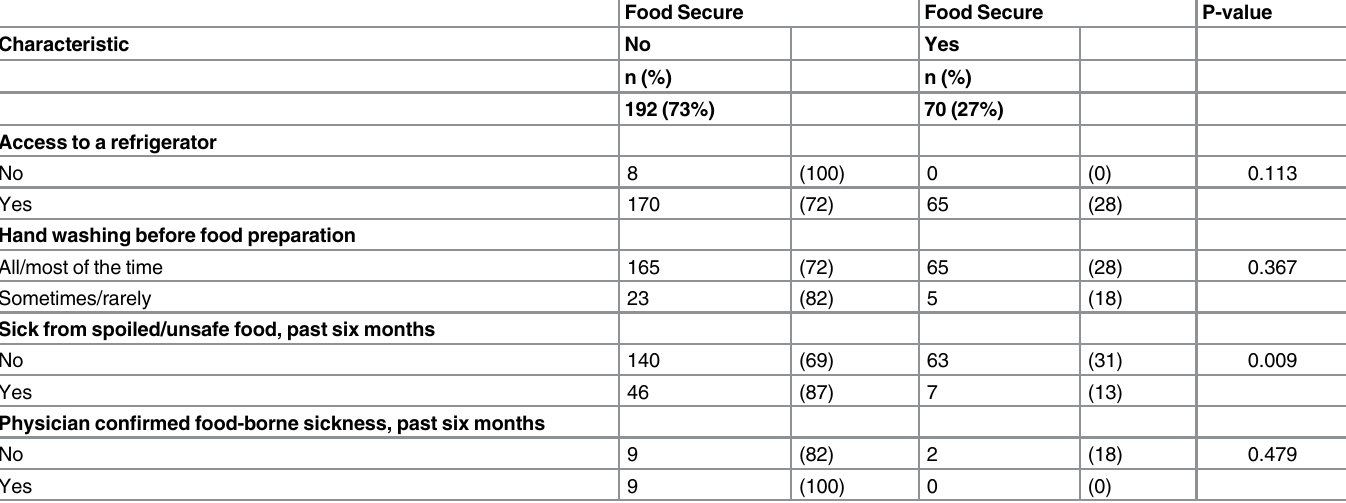
Table 5. Bivariate comparison of participant food safety by food security status (n =